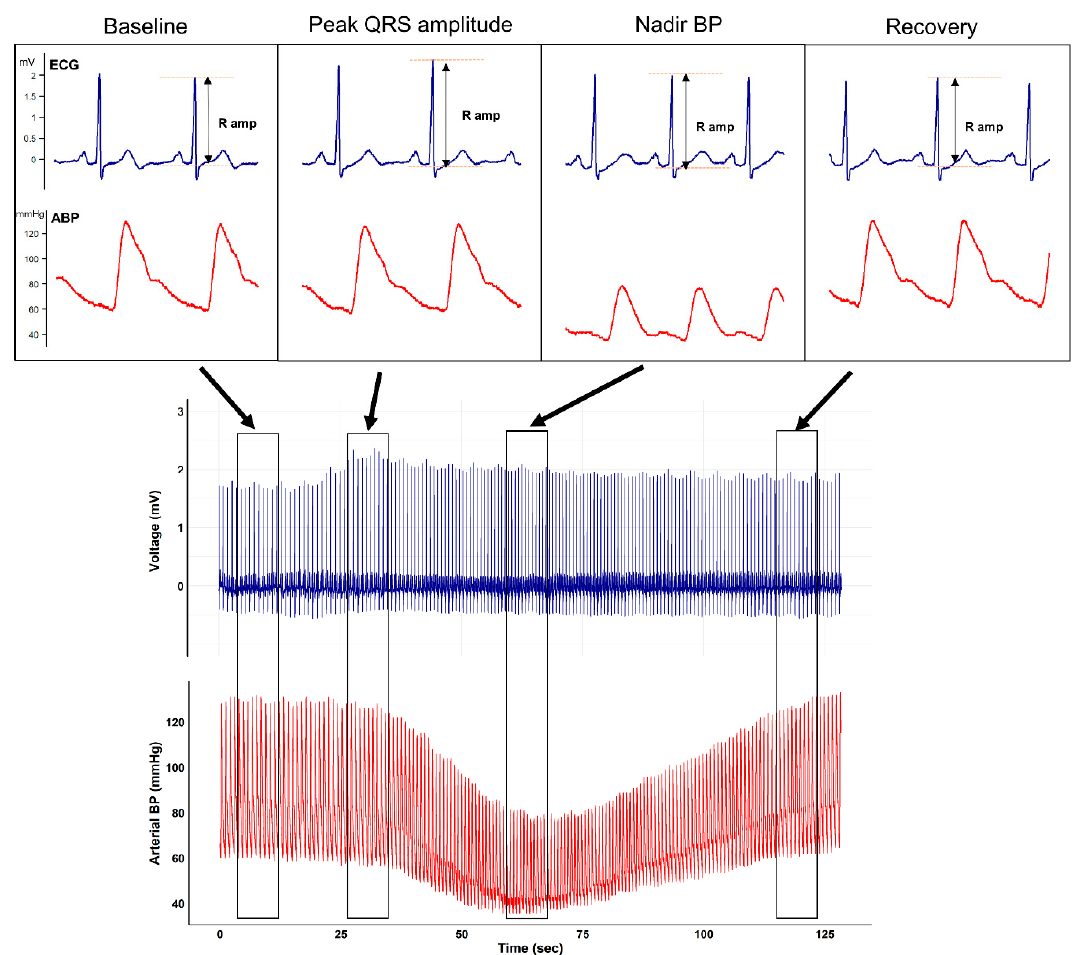
Figure 1. Representative beat-to-beat plot of the electrocardiogram and arterial waveform from an arbitrarily selected patient undergoing mobile contrast-enhanced computed tomography. After the injection of contrast agent, a characteristic QRS R-amplitude increase preceding nadir blood pressure is seen.